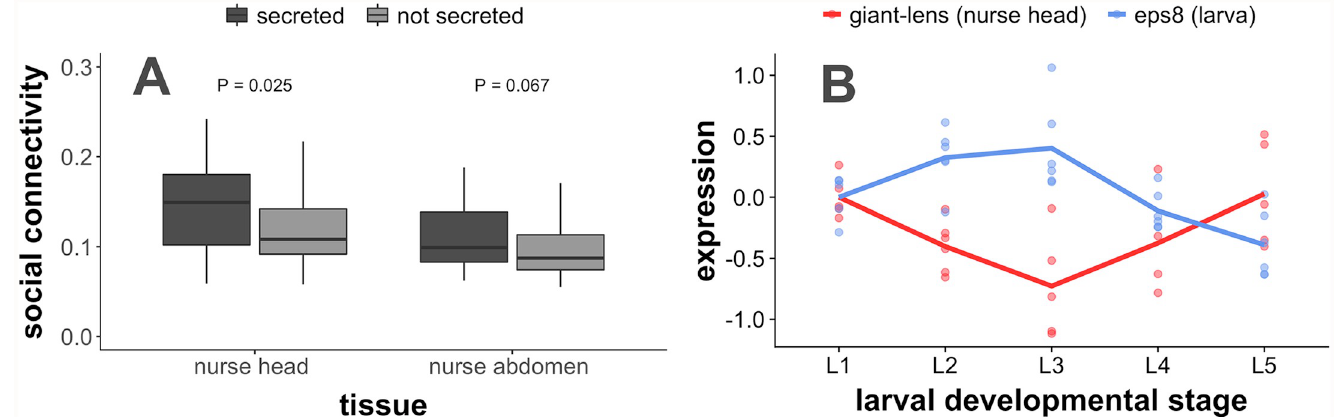
Fig 3. Genes encoding secreted proteins such as giant-lens are important for social gene regulation. (A) Genes encoding for proteins that are secreted in Drosophila melanogaster exhibit higher social connectivity (i.e. more strongly socially regulate larval expression) in nurse heads than genes encoding for non-secreted proteins (P- values from Wilcoxon test). (B) The protein giant-lens is one of the genes coding for secreted proteins with the highest social connectivity in nurse heads. Based on our data, giant-lens expressed in stage-specific nurse heads (red) appears to inhibit the expression of the homolog of human EGFR substrate 8 ( eps8 ) expressed in worker- destined larvae (blue). The expression of giant-lens in nurses of a given colony was negatively correlated to the expression of eps8 in larvae of the same sampled colony (rho = -0.270, P < 0.001, N = 25 colony/stage pairings after removing missing samples). Expression at stage i is equal to log 2 (expression i /expression 1 ), i.e. the ratio of expression at the given stage to expression at L1.